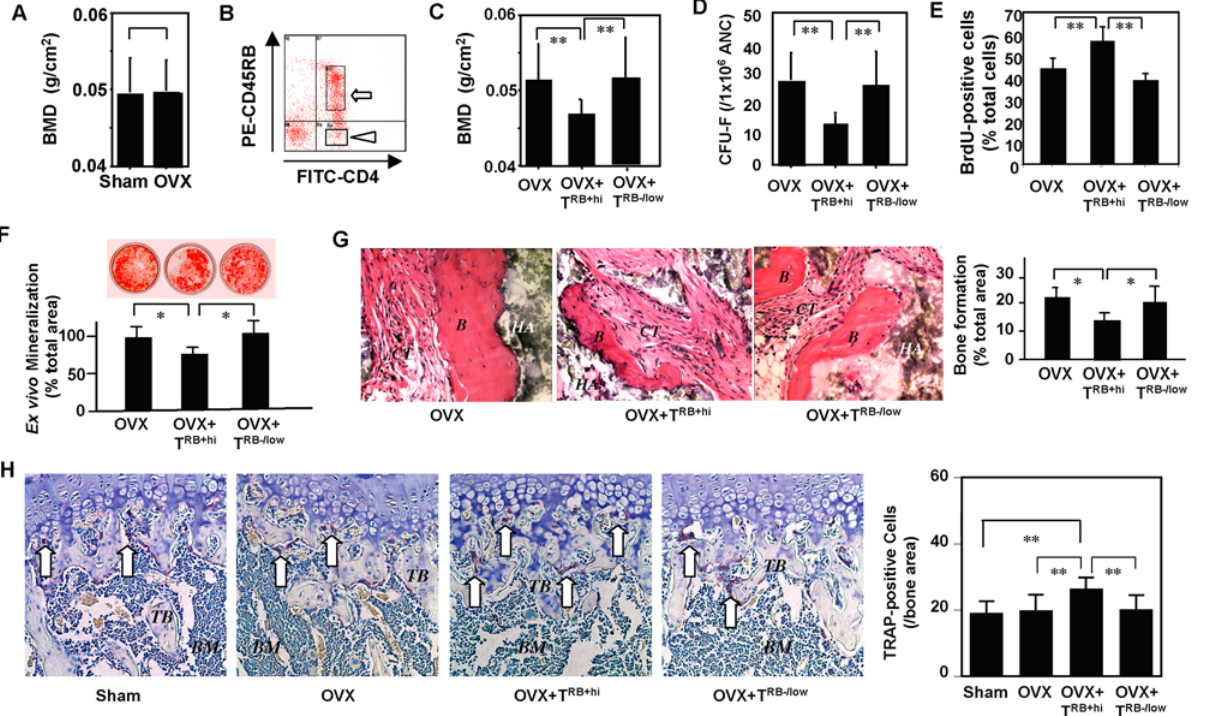
Figure 2. Adoptive transfer of CD4 + CD25 2 CD45RB + hi T cells derived from C3H mice restores bone loss phenotype in OVX- immunocompromised mice. ( A ) Estrogen-deficiency failed to induce osteoporosis in 15-week-old bg-nu/nu-xid immunocompromised mice. At one-month post-OVX, there is no BMD difference in femurs between OVX and sham group (n=4), assessed by Dual x-ray absorptiometry (DEXA) analysis. The graph represents mean 6 SD. ( B ) Isolation of CD4 + CD25 2 CD45RB + hi (open arrow) and CD4 + CD25 2 CD45RB 2 /low (triangle arrow) T cells from spleen of C3H mice by flow cytometry for systemic infusion. ( C ) At one month post-OVX, DEXA analysis revealed a significant decreased BMD in the femurs of CD4 + CD25 2 CD45RB + hi OVX mice (OVX + T RB + hi ) when compared to the OVX mice (OVX) or CD4 + CD25 2 CD45RB 2 /low OVX mice (OVX + T RB 2 /low ; n=4; [[ P , 0.01). ( D ) The number of CFU-F decreased significantly in CD4 + CD25 2 CD45RB + hi OVX mice (OVX + T RB + hi ) compared to OVX and CD4 + CD25 2 CD45RB 2 /low OVX mice (OVX + T RB 2 /low ). Totally 10 6 all nuclear cells (ANC) were used in each group. Error bars represent the mean 6 SD (n=5; [[ P , 0.01). ( E ) The proliferation of BMMSCs from CD4 + CD25 2 CD45RB + hi OVX mice (OVX + T RB + hi ) was significantly increased in compared to CD4 + CD25 2 CD45RB 2 /low OVX mice (OVX + T RB 2 /low ) and OVX mice as assessed by BrdU incorporation assay for 24 hours. The number of BrdU-positive cells was indicated as a percentage to the total number of counted BMMSCs and averaged from 5 replicated cultures. Error bars represent the mean 6 SD (n=5; [[ P , 0.001). ( F ) Alizarin red staining showed that BMMSCs derived from CD4 + CD25 2 CD45RB + hi OVX mice (OVX + T RB + hi ) had lower calcium accumulation than that of BMMSCs from OVX and CD4 + CD25 2 CD45RB 2 /low OVX mice (OVX + T RB 2 /low ) when cultured under the osteogenic inductive conditions. The graph represents mean 6 SD (OVX mice, n=4; CD4 + CD45RB + hi OVX mice, n=5; CD4 + CD45RB 2 /low OVX mice, n=4; [ P , 0.001). ( G ) BMMSCs were transplanted into immunocompromised mice using HA/TCP ( HA ) as a carrier for eight weeks. Bone formation assessed by H&E staining was decreased in transplants of BMMSCs derived from CD4 + CD25 2 CD45RB + hi OVX mice (OVX + T RB + hi ) compared to BMMSC transplants of OVX and CD4 + CD25 2 CD45RB 2 /low OVX mice (OVX + T RB 2 /low ). B ; bone CT ; connective tissue. Original magnification; 6 200. The graph represents mean 6 SD (OVX mice, n=4; CD4 + CD45RB + hi OVX mice, n=5; CD4 + CD45RB 2 /low OVX mice, n=4; [ P , 0.001). ( H ) TRAP staining showed that 15-week old OVX mice received CD4 + CD45RB hi cells (OVX + T RB + hi ) contain elevated number of TRAP-positive osteoclastic cells (white arrows) in epiphysis and trabecular bone areas of femurs as compared to Sham, OVX, and OVX received CD4 + CD45RB 2 /low cells (OVX + T RB 2 /low ). The graph represents mean 6 SD (n=4; [ P , 0.05, [[ P , 0.01). BM: bone marrow, TB: trabecular bone.